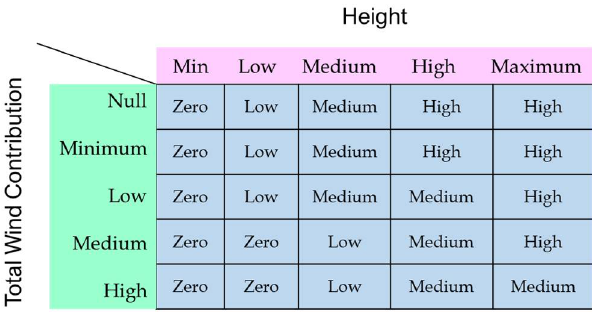
Figure 8. Inference rules of the hydropower fuzzy system.